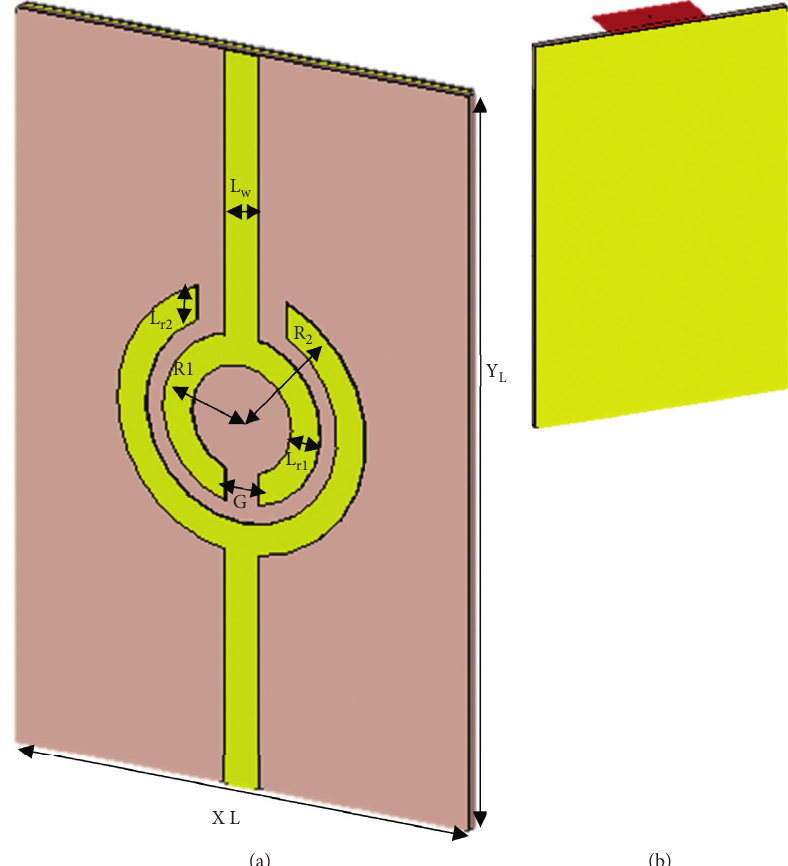
Figure 1: Design of proposed metamaterial-based SRR: (a) top view and (b) bottom view (full ground plane). Table 1: Dimensions of the split-ring resonator in mm. Parameter Value (mm) Parameter